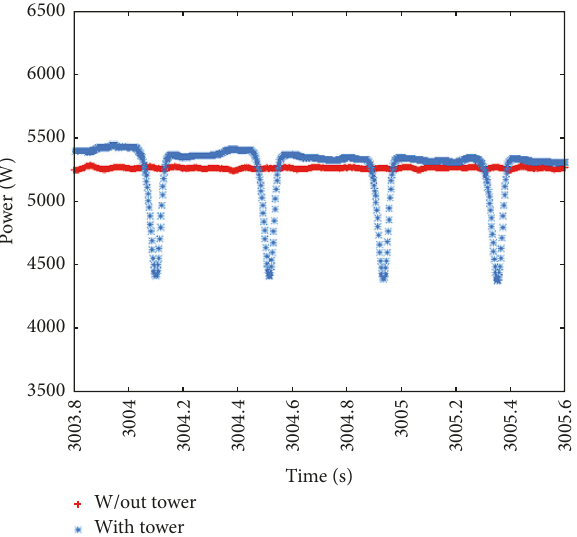
Figure 9: Output power comparison between isolated rotor and rotor-AL